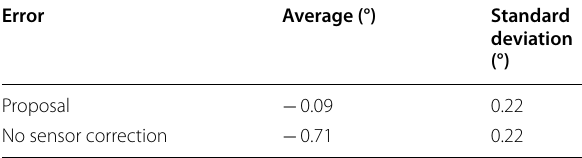
Fig. 13 Error of estimated roll angle (Urban highway) Table 2 Error of estimated roll angle (Urban street)